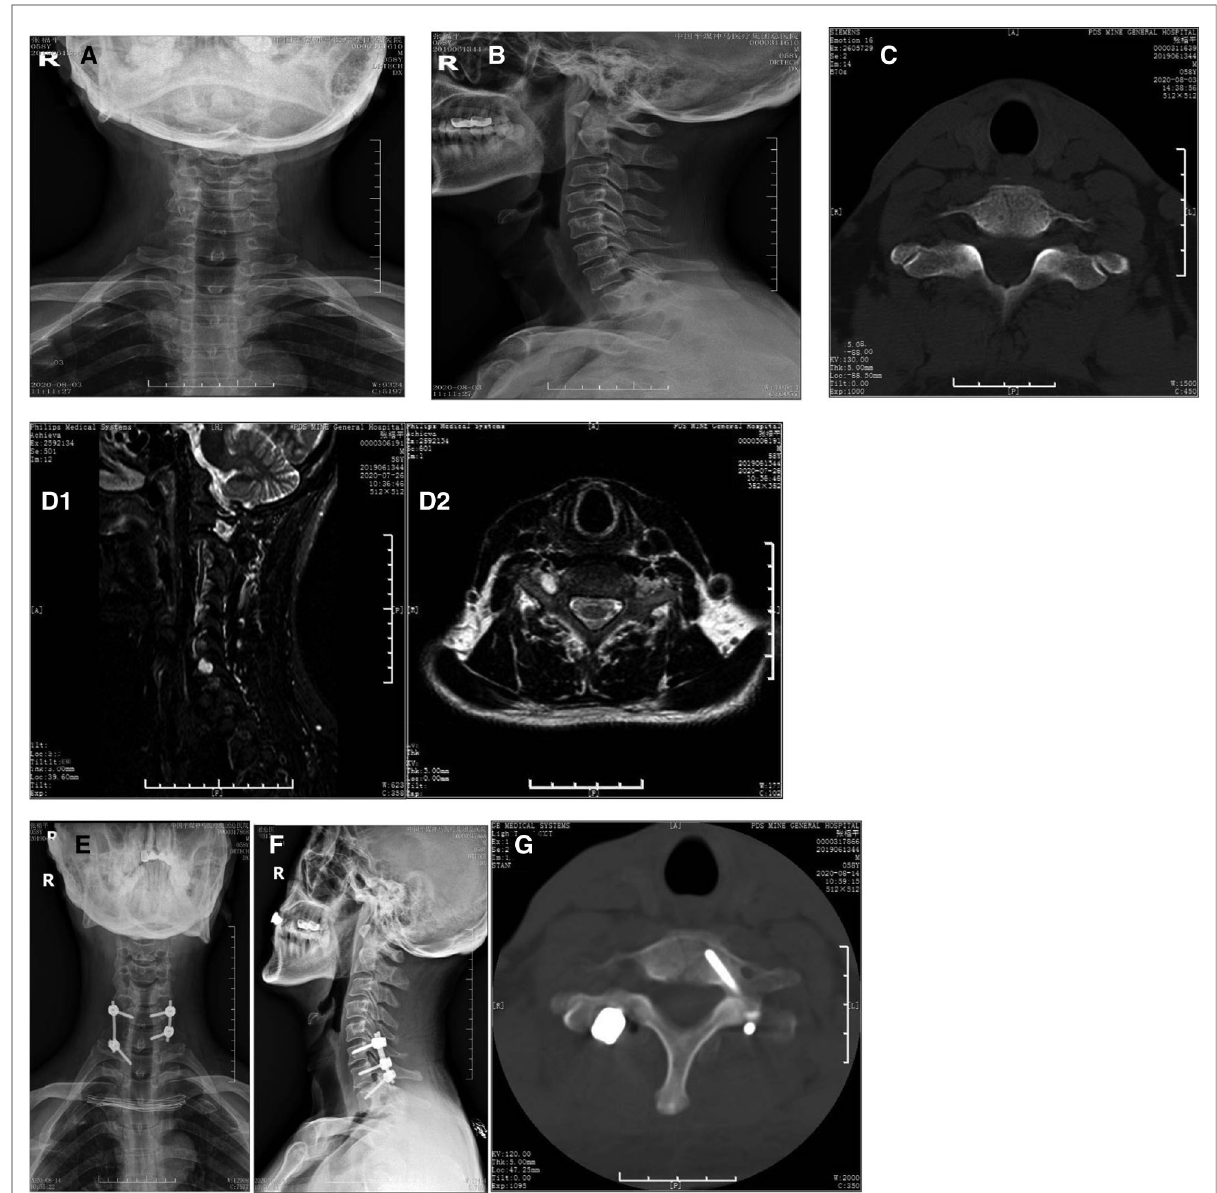
FIGURE 1 C7 nerve root cyst removed by microscope-assisted surgery. A 58-year-old man with a C7 nerve root cyst presented with neurological symptoms and was operated by microscope-assisted cystectomy with decompression of the cervical facet joints and internal fi xation using screws. ( A,B ) Preoperative anterior ( A ) and lateral ( B ) Radiograph images of the cervical spine; no abnormality in the cervical spine is observed as shown on preoperative radiograph images. ( C ) Preoperative CT scans of the cervical spine. ( D ) Preoperative MRI scans of the cervical spine. The preoperative MRI shows abnormal signals in the right intervertebral foramina of the C6-7 segments, indicating a nerve root sleeve cyst. ( E,F ) Postoperative anterior ( E ) and lateral ( F ) radiograph images of the cervical spine; the postoperative radiograph images show that the cervical spine is well fi xed. ( G ) The preoperative CT shows that the right neck of the C6-7 pedicle foramen is enlarged, the postoperative CT shows that the cervical spine is well fi xed. R: